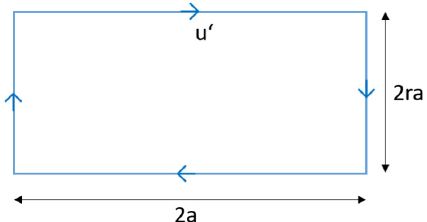
FIG. 10. Thin wire moving around a rectangular area.